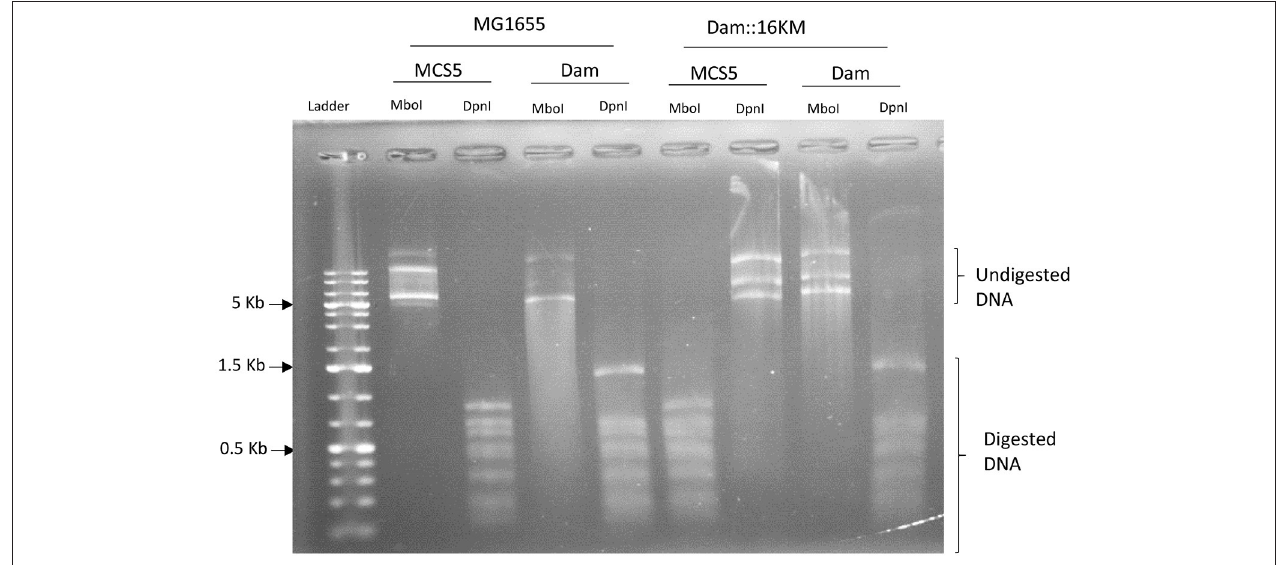
FIGURE 1 | Differential plasmid DNA digestion from E. coli. An E. coli dam mutant (Dam::16KM) or its parental strain (MG1655) were complemented with either a plasmid harboring the P. luminescens dam gene (Dam) or the pBBR1-MCS5 empty vector (MCS5). Plasmid DNA was extracted and digested by MboI (active on unmethylated 5 ′ -GATC-3 ′ sites) or DpnI (active on 5 ′ -GmeATC-3 ′ sites). pBBR1-MCS5 (4,768 bp) has 17 GATC sites and pBB-Dam (5,618 bp) has 19 GATC sites.